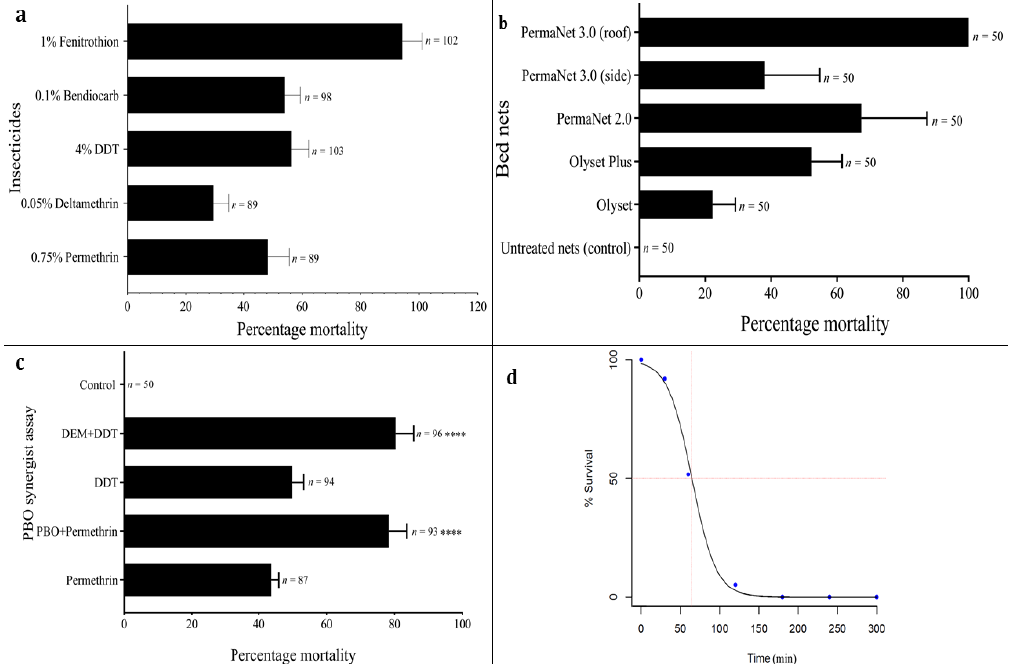
Figure 2. Resistance profiles of F 1 An. funestus females. ( a ). Results of WHO susceptibility bioassays with various insecticides. Results are the average of percentage mortalities from four replicates each ± standard error of mean (SEM); ( b ). Results of the cone bioassays with PermaNet ® 3.0 (side and roof), PermaNet ® 2.0, Olyset ® Plus and Olyset ® Net. Results are the average of